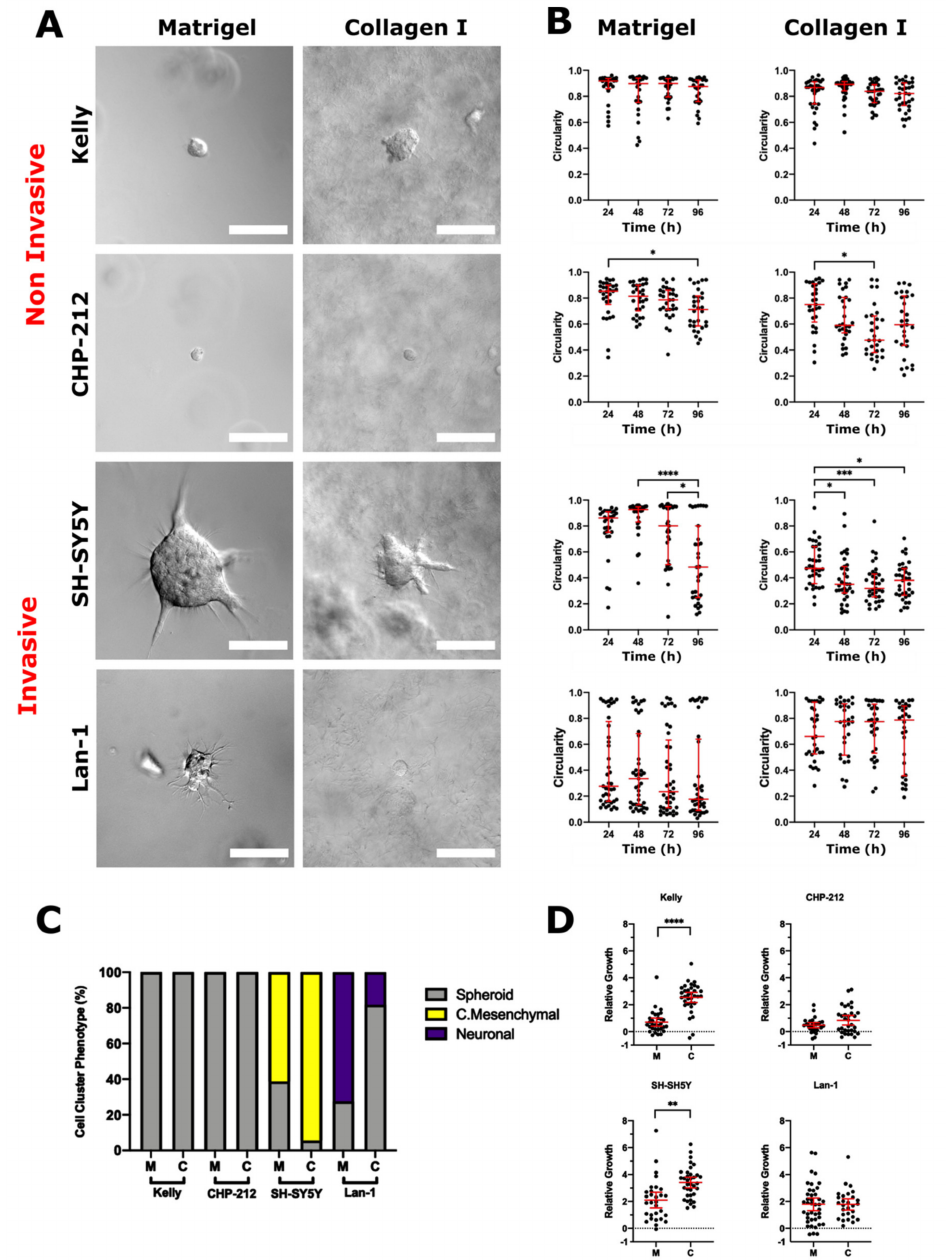
Figure 4. ECM microenvironments modulate the pattern of collective invasion and local dissemination in human neuroblas- toma cells. ( A ) Representative DIC images of NB cell clusters grown in 3D ECM cultures at 96 h. Based on the morphology NB cell clusters were classified as non-invasive (spheroid, cyst) or invasive (elongated, collective mesenchymal, neuronal or protrusive). ( B ) Cell cluster circularity was measured at 96 h in Matrigel and collagen (Kruskal–Wallis and Dunn’s post-hoc tests; horizontal bars represent median and interquartile range). ( C ) Corresponding bar charts represent phenotype classifications. ( D ) The relative growth of these clusters was calculated by dividing the difference in area between 0 h and 96 h by the area at 0 h. Each dot represents the relative growth of one cell cluster (Matrigel: n = 31 for Kelly, n = 30 for CHP-212, n = 30 for SH-SY5Y, n = 41 for Lan-1; collagen: n = 30 for Kelly, n = 29 for CHP-212, n = 34 for SH-SY5Y, n = 34 for Lan-1). Error bars indicate the mean ± 95% confidence interval. Asterisks indicate statistical significance obtained using Brown–Forsythe ANOVA with T3 Dunnett post-hoc test (ns, not significant, * p < 0.05, ** p < 0.01, *** p < 0.001, **** p < 0.0001). Scale bars = 30 (Kelly, CHP-212), 50 (Lan-1) and 100 µ M